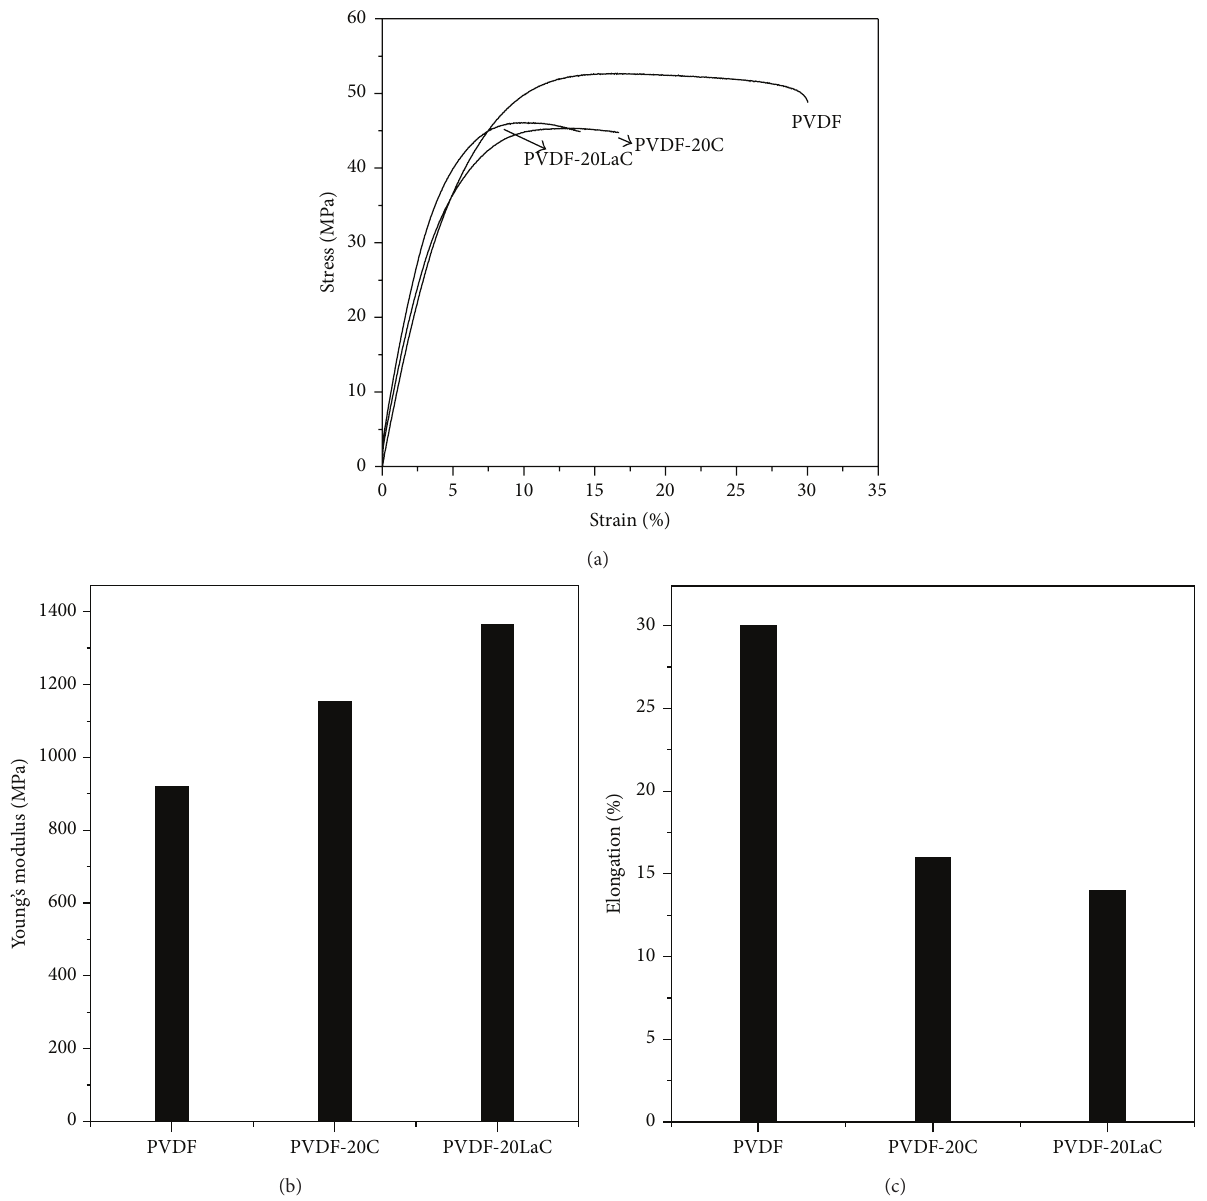
Figure 3: Stress-strain curves, Young’s modulus, and elongation ((a)–(c)) for pure PVDF, PVDF-20C, and PVDF-20LaC composites.